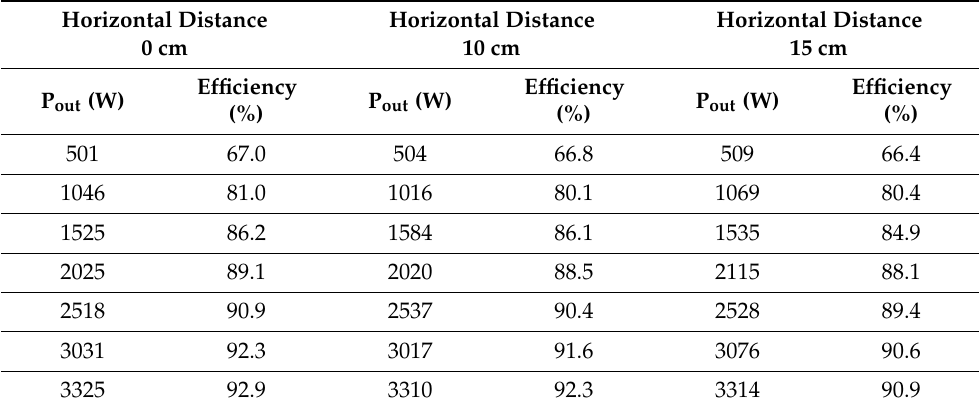
Table 3. Efficiency data of circular 2-coil